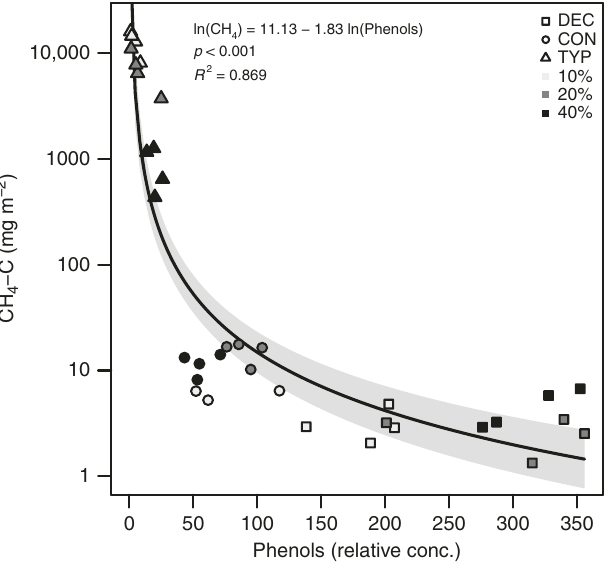
Fig. 3 CH 4 production in sediments declines with phenols. The relationship is shown across OM amendment type (DEC, CON, and TYP) and concentrations (10, 20, 40%), with 95% CI shaded. Concentrations of phenols are relative and determined from fl uorescence excitation-emission